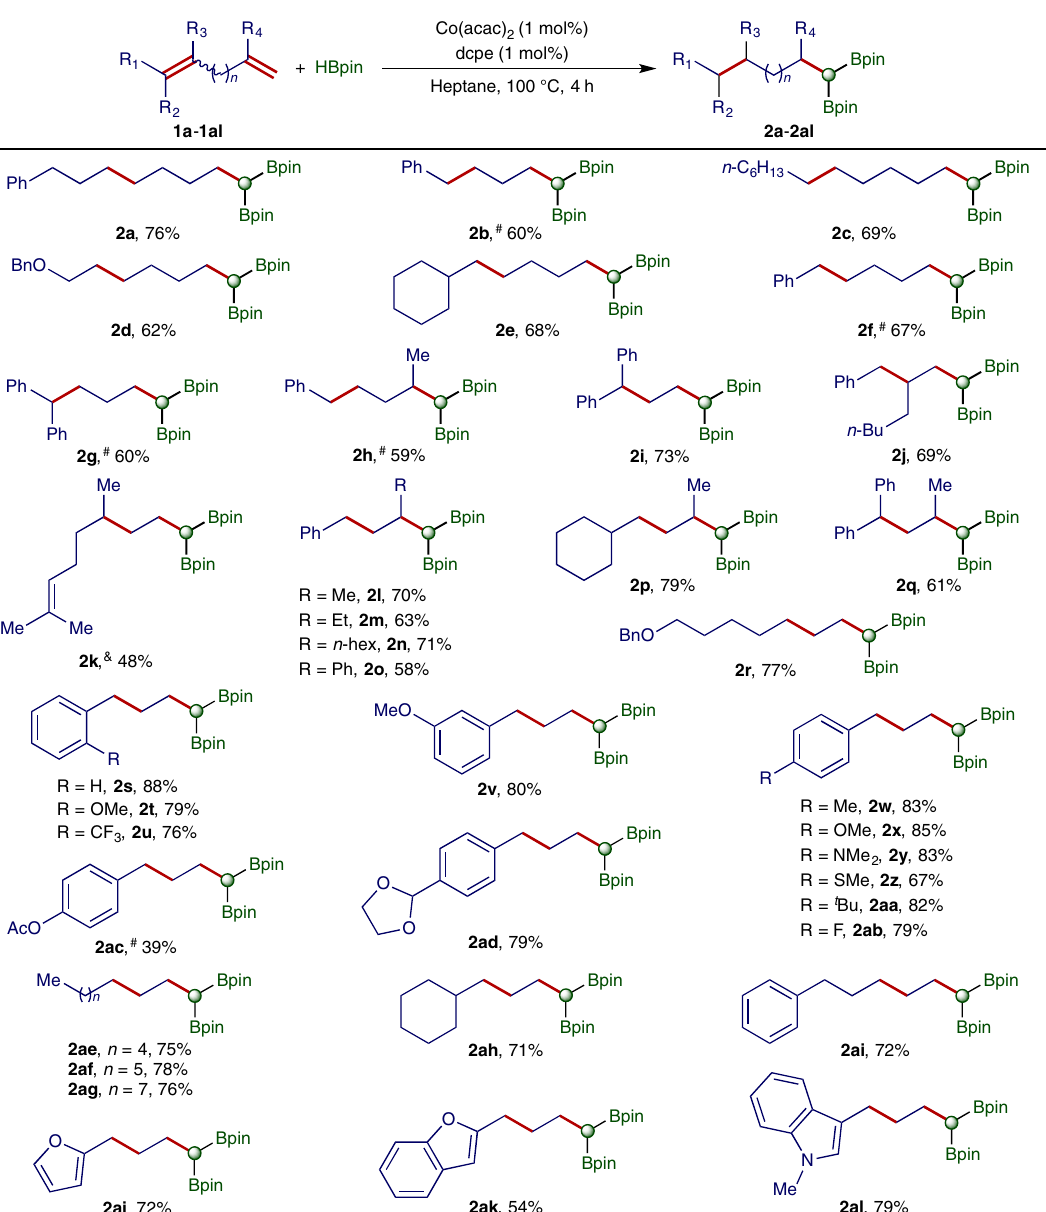
Fig. 3 Scope of 1,n-dienes. Reaction conditions: 1,n-diene (0.300 mmol), HBpin (0.750 mmol), Co(acac) 2 (3.0 μ mol), dcpe (3.0 μ mol), heptane (0.5 mL), 100 °C, 4 h, and isolated yields. # 3 mol % catalyst; & 80